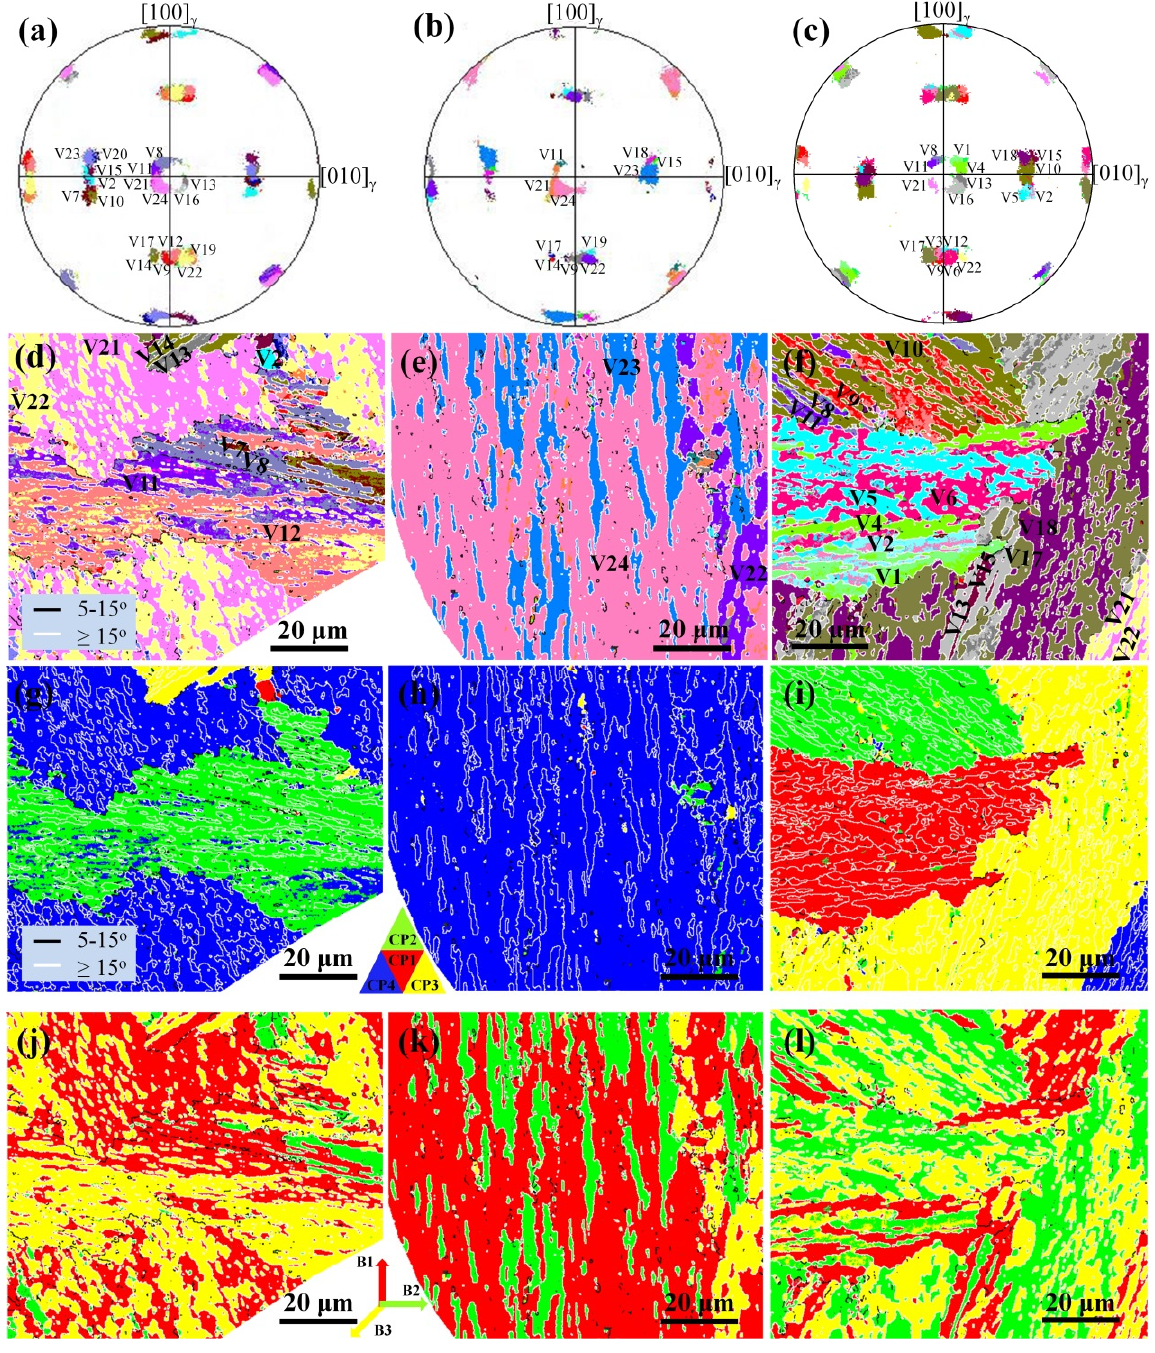
Figure 6. ( a – c ) the (001) γ stereographic projection on which <001> α directions with a K–S OR to γ in single prior austenite grain, ( d – f ) variant identification and IPF maps colored according to ( g – i ) CP group and ( j – l ) Bain group: ( a , d , g , j ) IT698, ( b , e , h , k ) IT673 and ( c , f , i , l ) IT623. (V1: variant 1; . . . V24: variant 24. B1: Bain 1; . . . B3: Bain